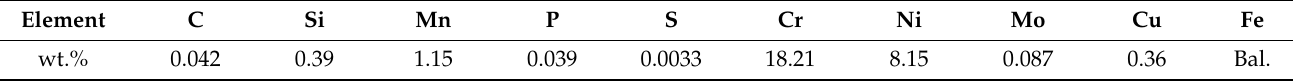
Table 1. Chemical composition of AISI 304 stainless steel